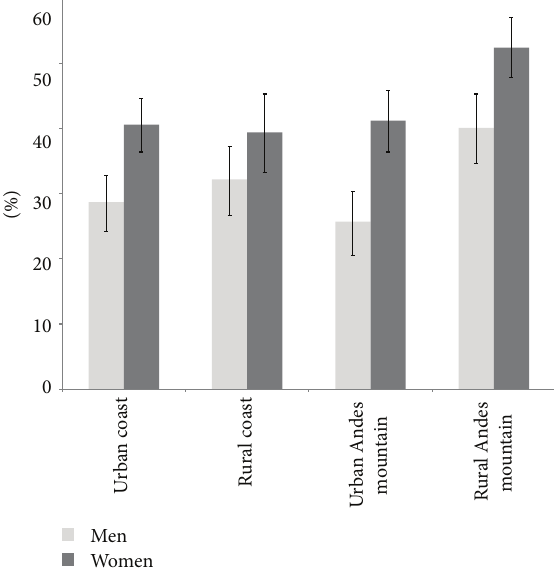
Figure 2: Prevalence of falls among older adults according to area of residence.